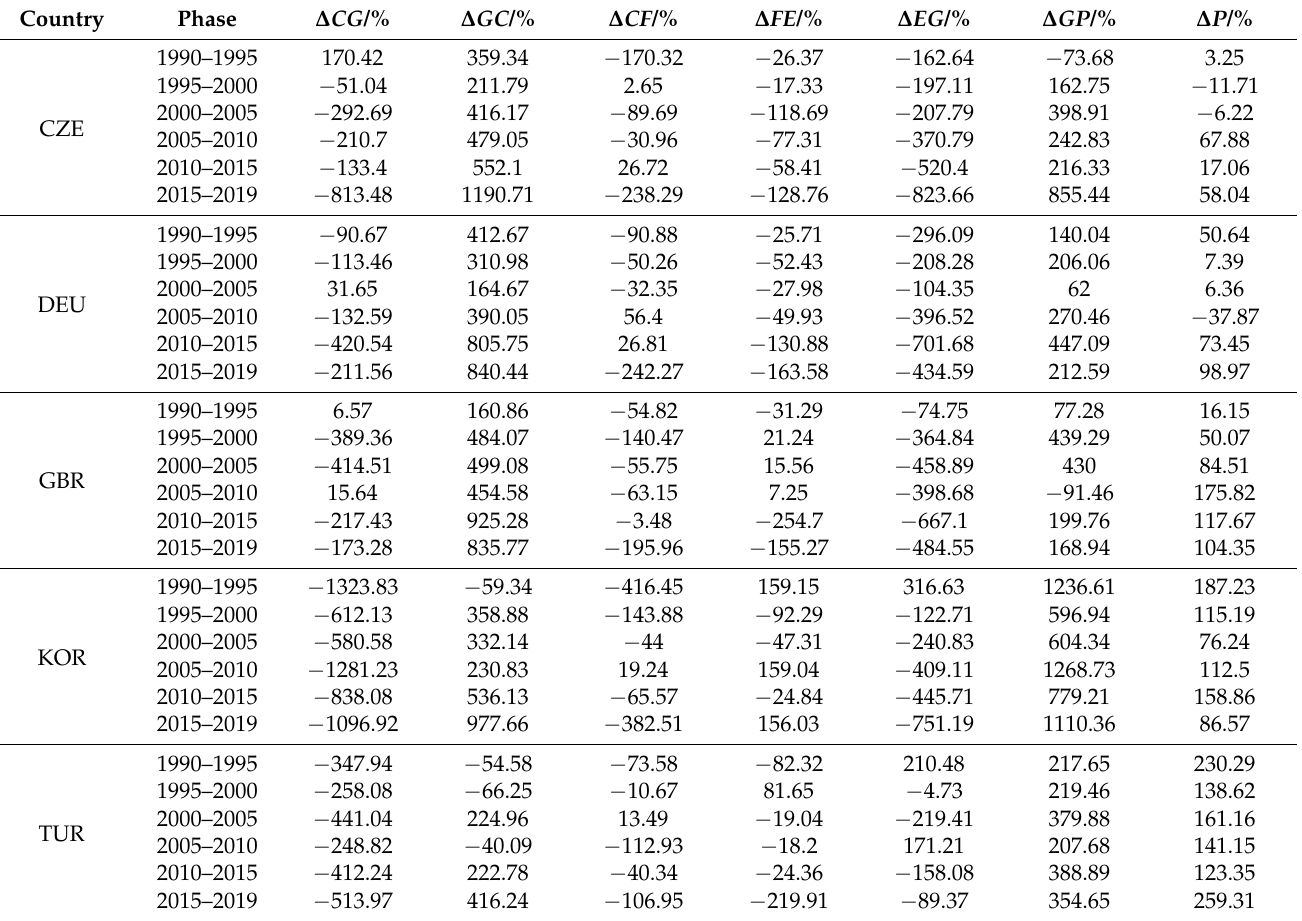
Table 3. Decomposition of CEP for the example